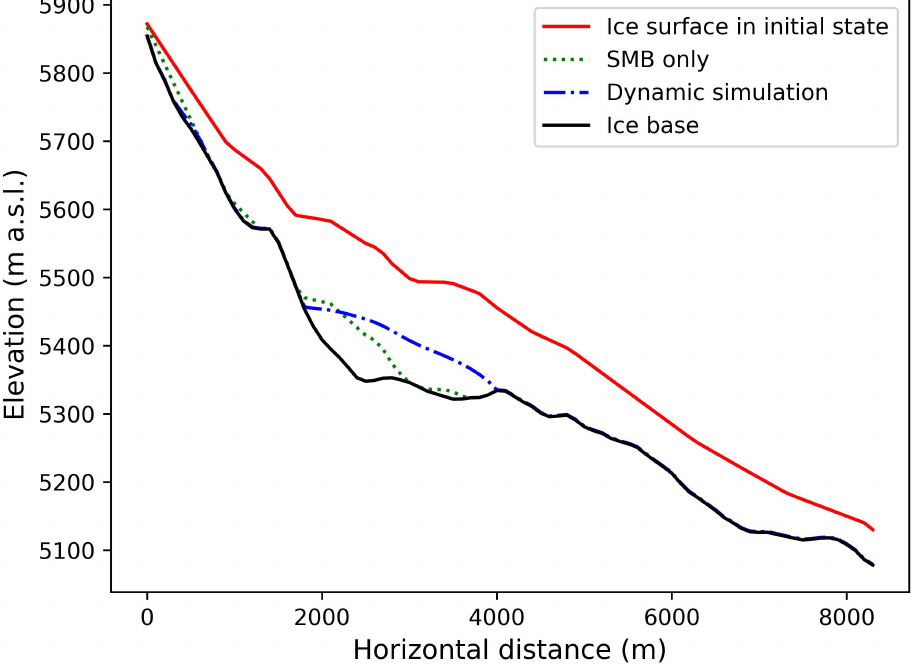
Figure 10. Future ice surface evolution of JMYZG in 2100 under SSP5-8.5. The red and black solid line are the ice surface in the initial state (2011) and the ice-bedrock interface, respectively. The green dotted line is the ice surface in the case of the SMB only, and the blue dash-dotted line is the ice surface in the dynamic